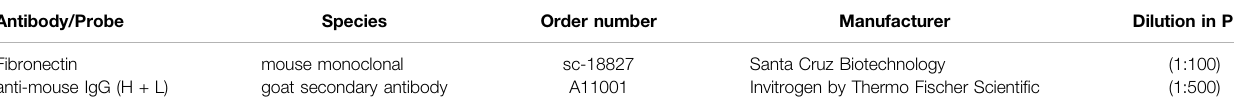
TABLE 2 | Materials used for immuno fl